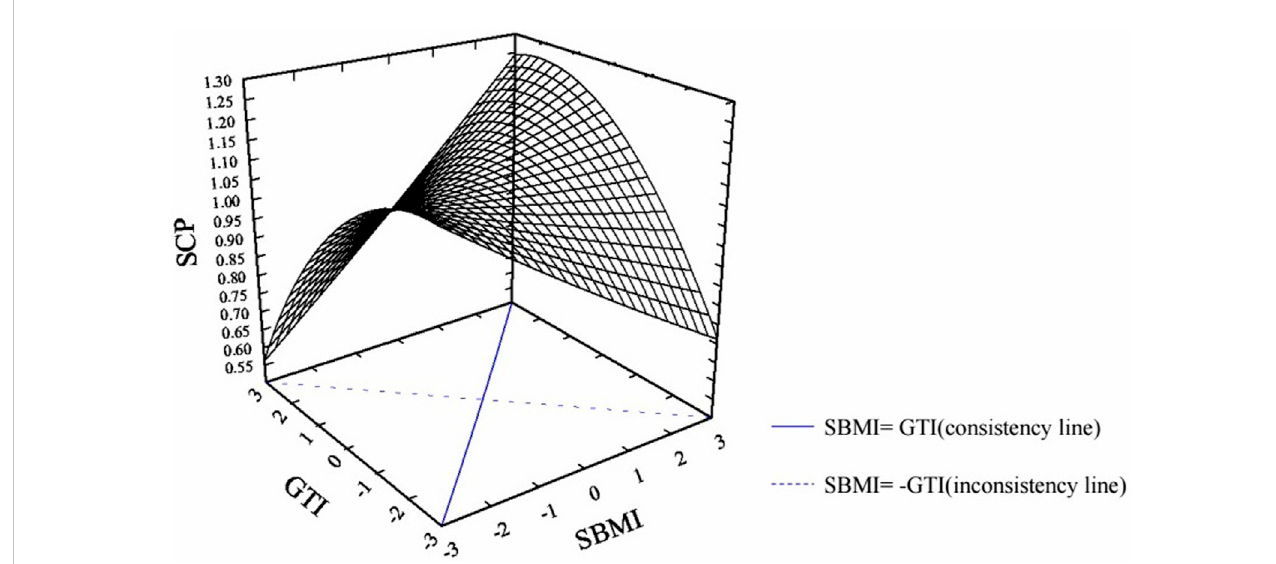
FIGURE 4 Surface graph of SBMI-GTI consistency/inconsistency on SCP.